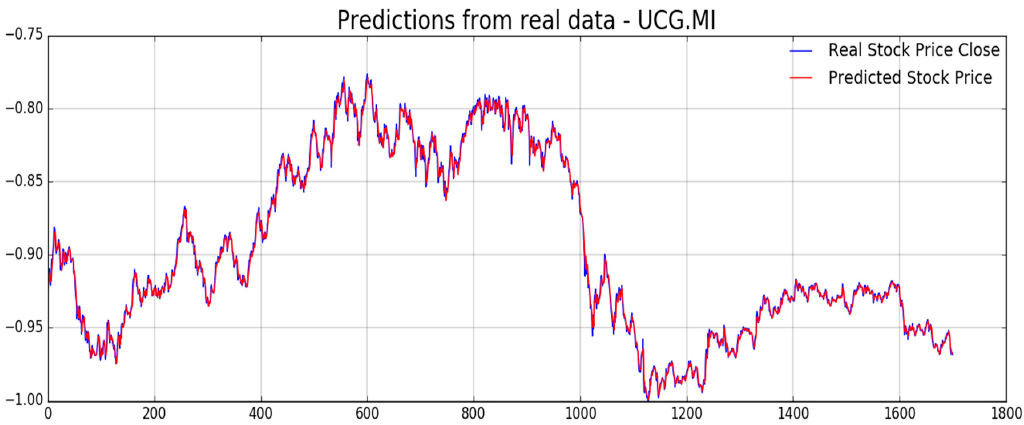
Figure 17. UCG.MI Close Price time-serie (red: predicted; blue: real value).